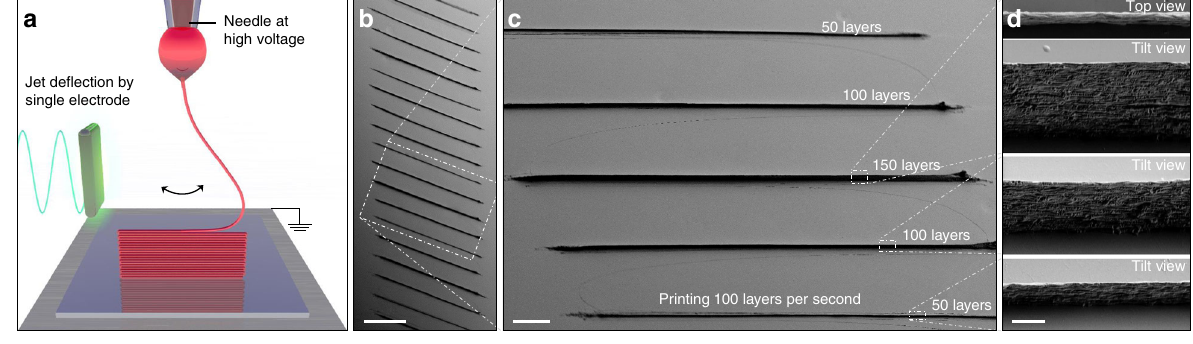
Fig. 4 Printing 3D walls. a Schematic of the 3D printing of a wall. b – d SEM micrographs of PEO walls built by layer-by-layer assembly at a jet oscillation frequency of 50 Hz, thus depositing two layers per period. Each wall was printed using exclusively electrostatic jet de fl ection to position the material on the substrate. The XY translation stage was moved only in between walls. The periodic de fl ection of the jet during 1.5, 1 and 0.5 s resulted in walls of variable height, composed of 150 layers, 100 layers and 50 layers, respectively. SEM micrographs in d shows the top view of the wall composed of 150 layers and the 45° tilt view of walls composed of 150, 100 and 50 layers. Scale bars ( b , c ): 200 µ m and 50 µ m. All SEM micrographs on d have the same scale of 2 µ